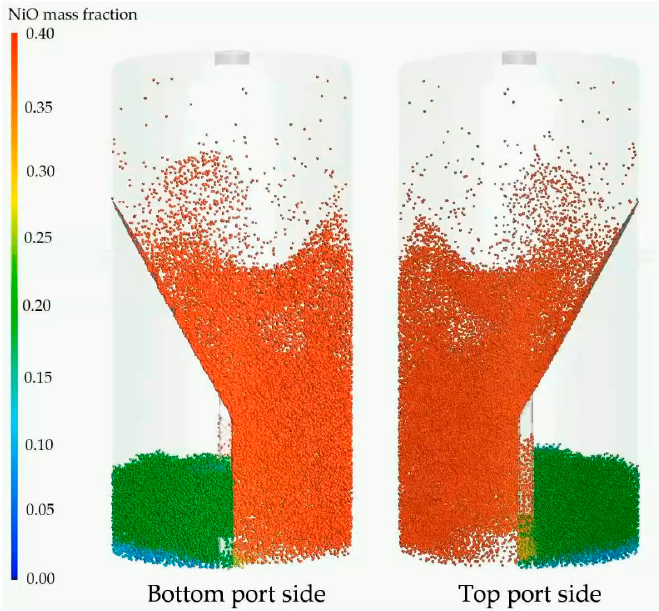
Figure 5. Particle plot of the instantaneous NiO mass fraction. A corresponding animation is provided in Video S1. Note that the particles pictured are tracers following the continuous solids flow for visualization purposes and do not influence the simulation solution.